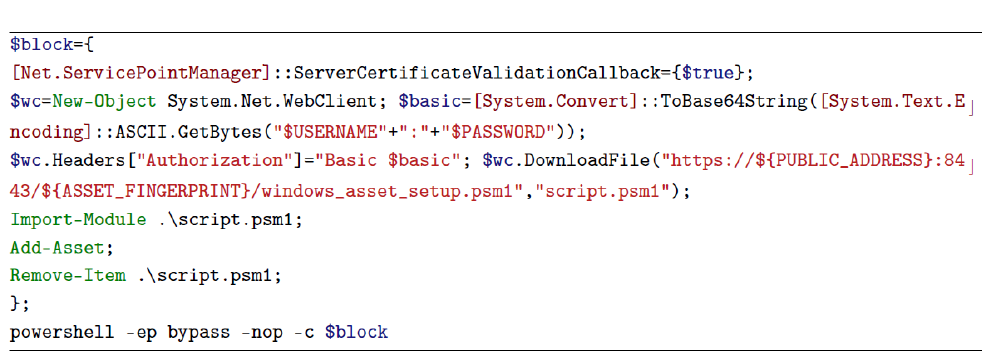
Figure 3. Asset joining one-liner for